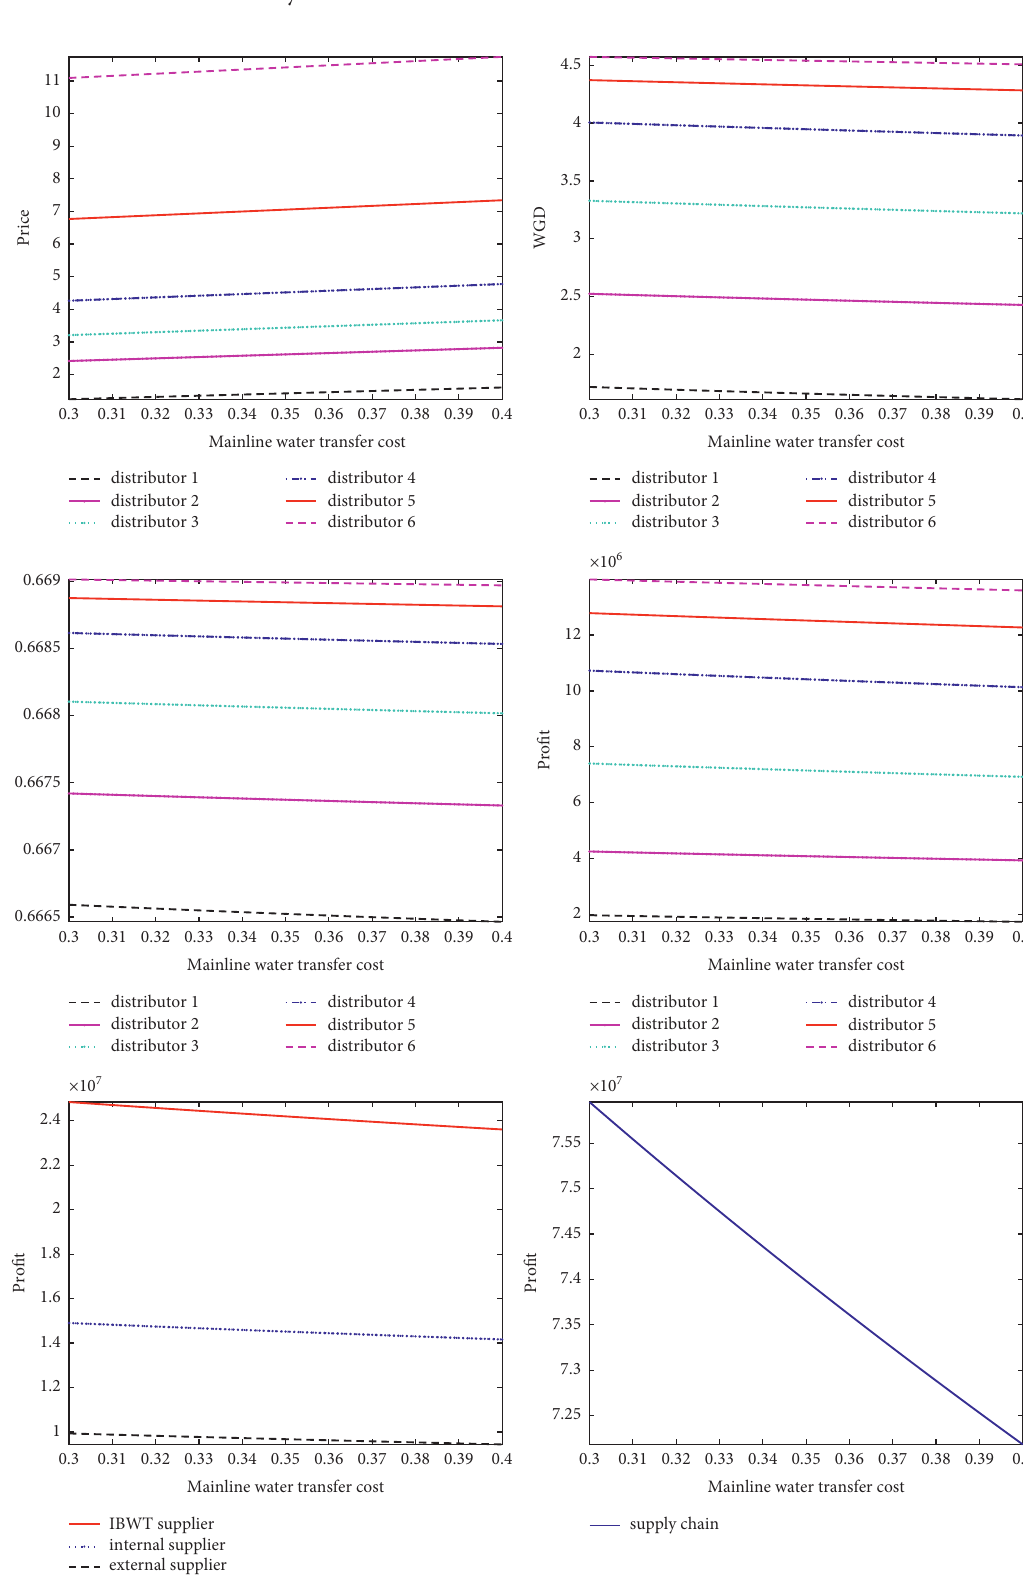
Figure 5: Sensitivity analysis of mainline water transfer cost